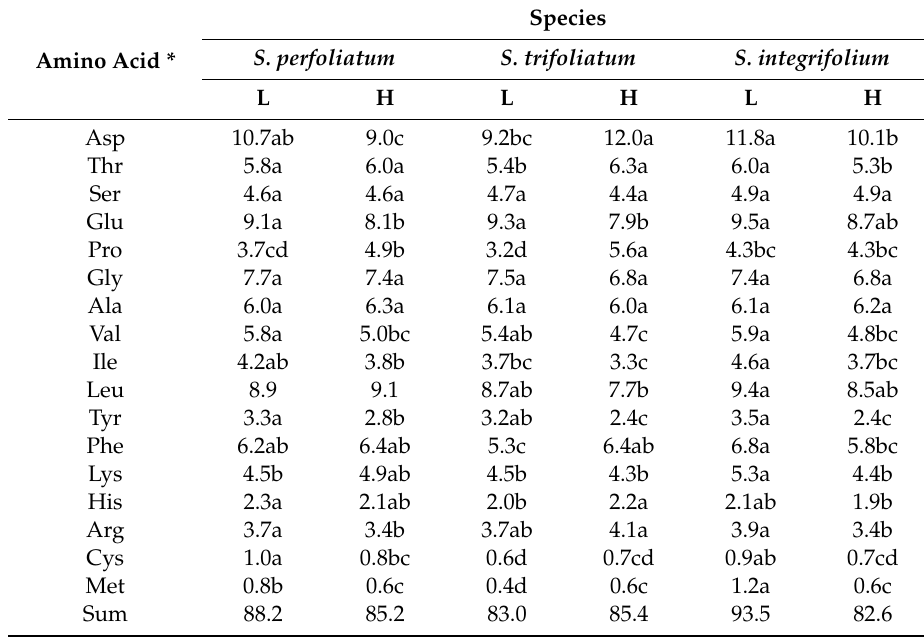
Table 6. Percentage of amino acids in total protein of three Silphium species leaves (L) and herbs (H).